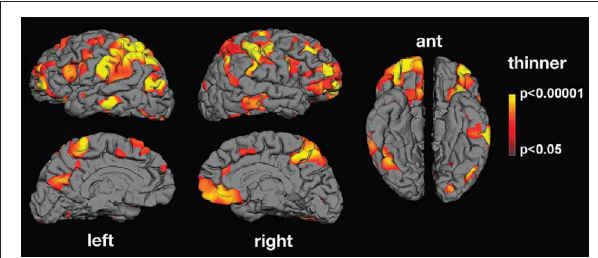
FIGURE 2 | Mean thickness difference significance maps. Lateral, medial, and ventral views of the brain showing areas presenting cortical thinning in the autism group compared with neurotypical controls. Significant thinning was found in areas belonging to the MNS (inferior frontal gyrus, inferior parietal lobule, and superior temporal sulcus) as well as in areas involved in facial expression production and recognition (face regions in sensory and motor cortex and in middle temporal gyrus), imitation (superior parietal lobule), and social cognition (prefrontal cortex, anterior cingulate, medial parietal cortex, supramarginal gyrus, and middle and inferior temporal cortex; from Hadjikhani et al.,